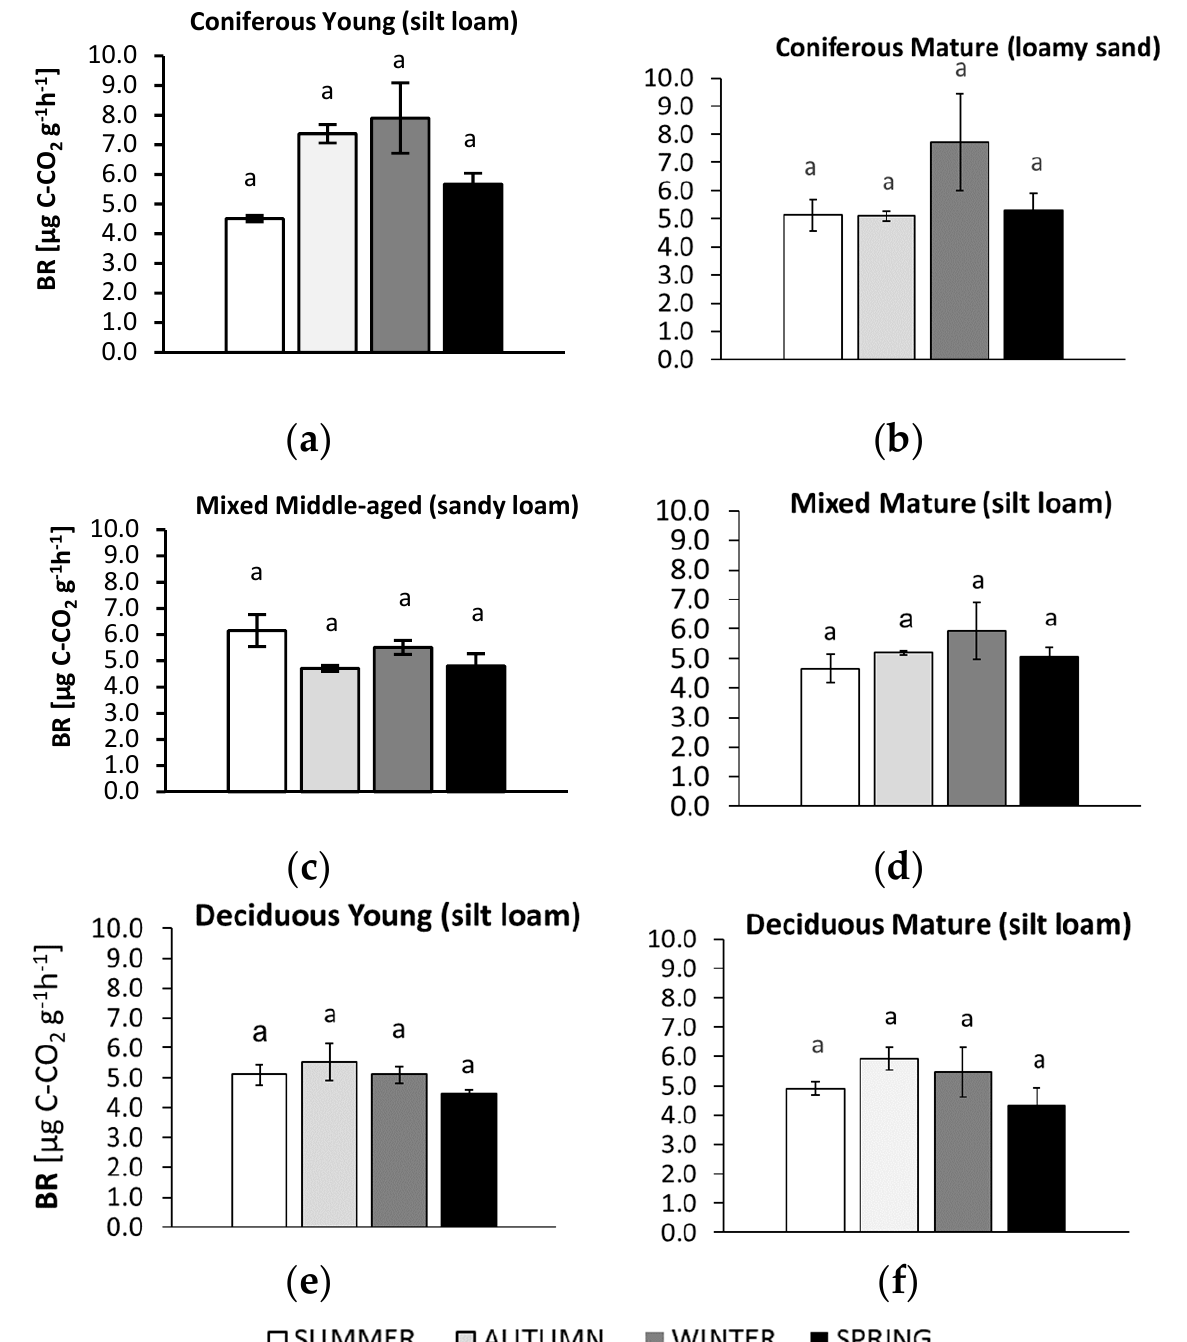
Figure 3. Basal respiration (BR) in soil samples collected in summer, autumn, winter, and spring from different forest sites (average values ± standard deviation; n = 3). ( a ) Coniferous Young (silt loam); ( b ) Coniferous Mature (loam sand); ( c ) Mixed Middle-aged (sandy loam); ( d ) Mixed Mature (silt loam); ( e ) Deciduous Young (silt loam); ( f ) Deciduous Mature (silt loam). Different letters indicate significant differences (a non-parametric Kruskal–Wallis test, p < 0.05, was carried out separately for each season and for each forest).